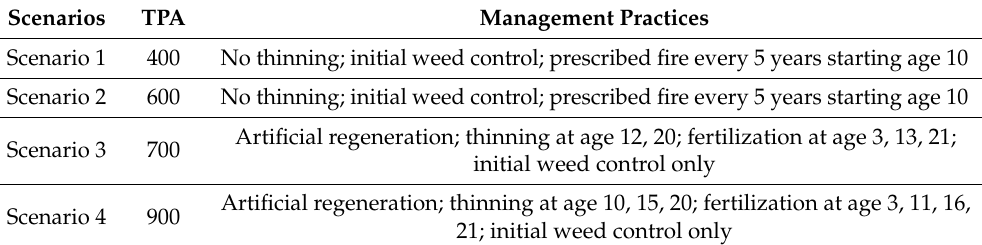
Table 1. Scenarios for the